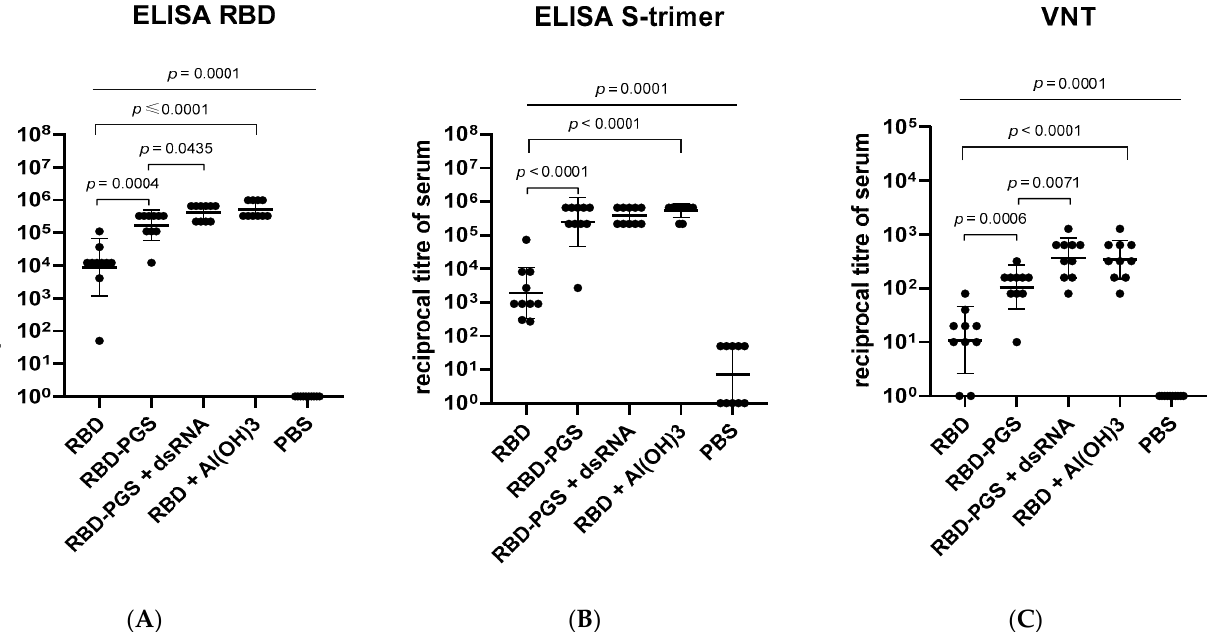
Figure 2. Immune response to the conjugated RBD in BALB/c mice: ( A ) Serum IgG specificity to recombinant RBD in ELISA; ( B ) Serum IgG specificity to recombinant S protein in ELISA; ( C ) Serum neutralization titers against SARS-CoV-2/Victoria/1/2020. The data were plotted as the geometric mean ± SD. Statistical analyses were performed using the Mann–Whitney U test and Kruskal–Wallis H tests. p -values indicate statistical significance.